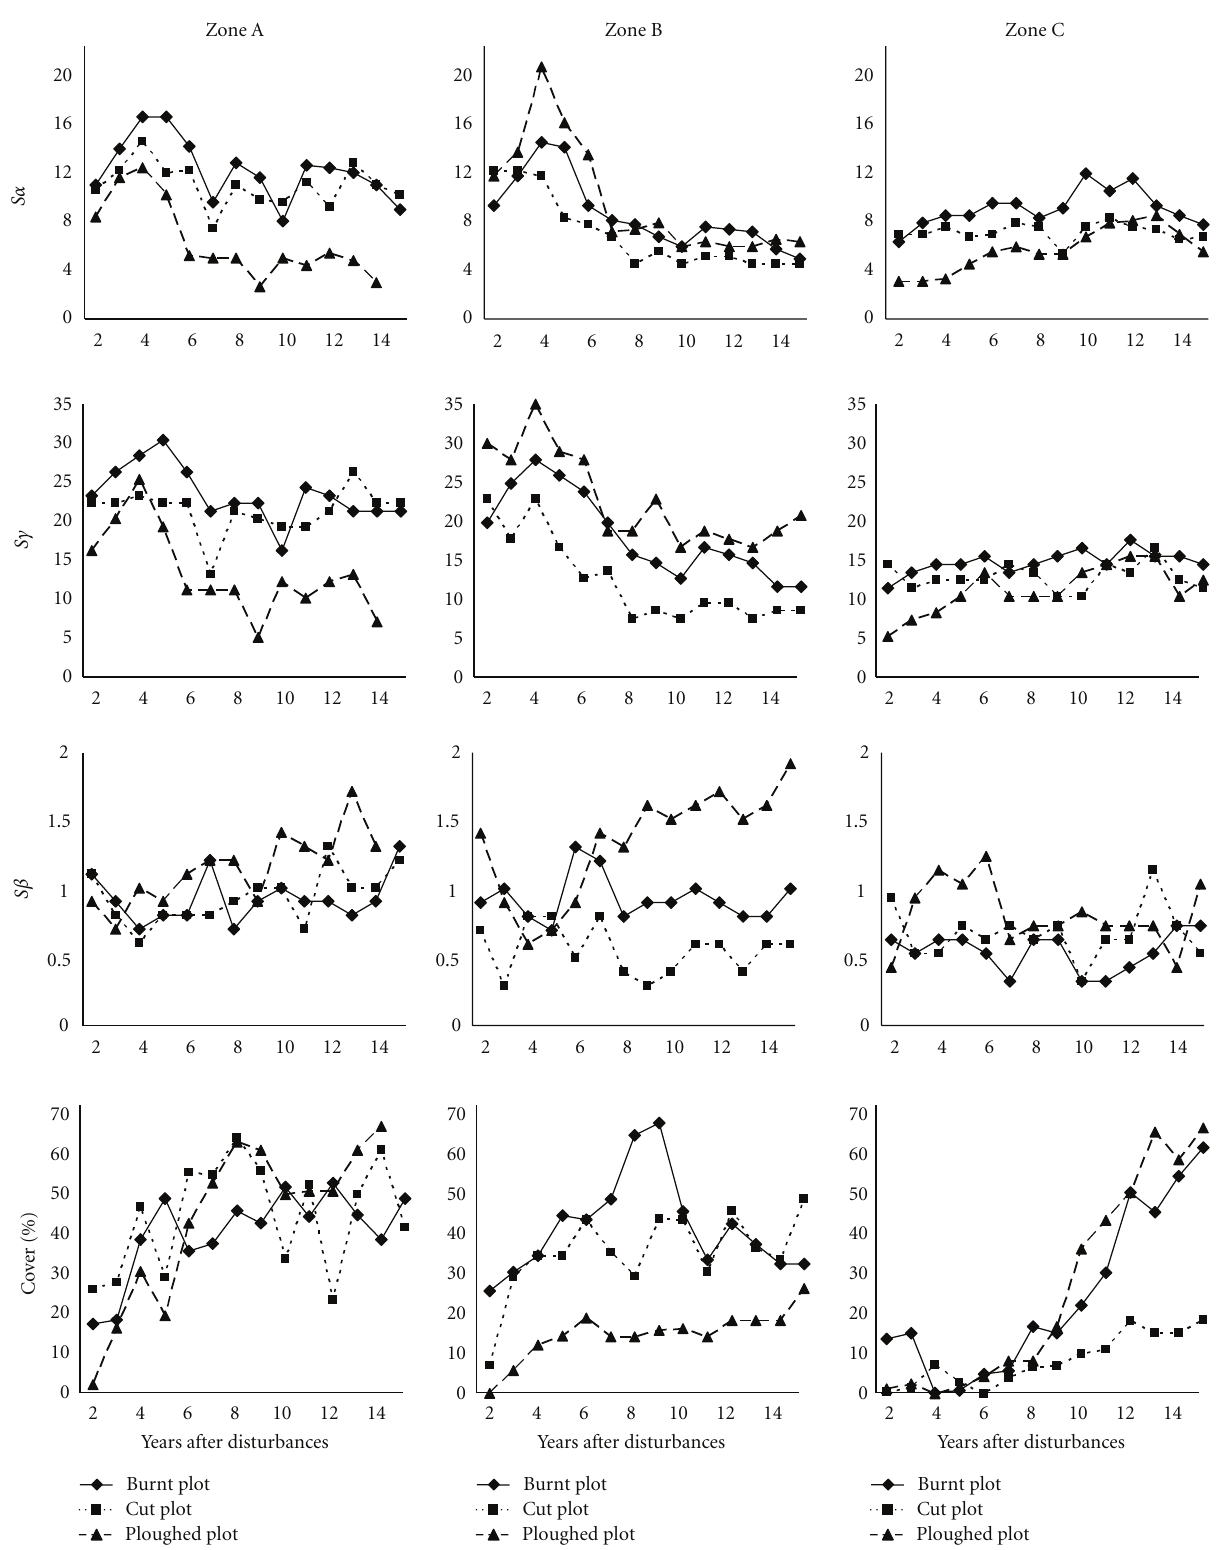
Figure 2: Diversity values ( S α , S γ , S β ) and mean cover of dominant species after burning, cutting, and ploughing in the three study zones (A, B, and C) during the study period (2 to 15